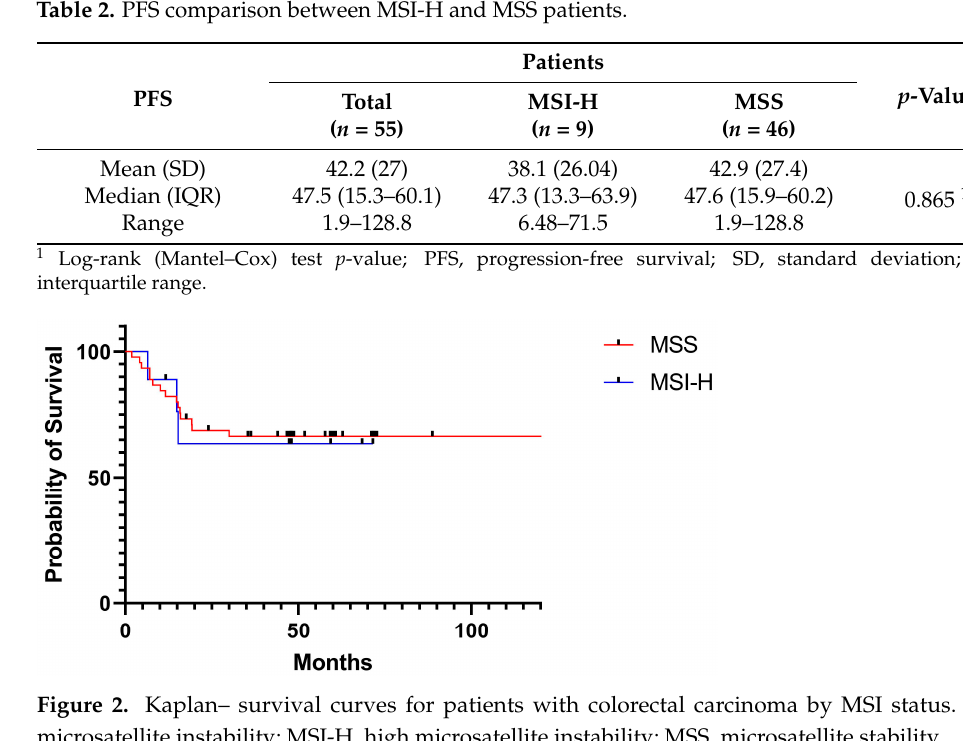
Table 2. PFS comparison between MSI-H and MSS patients.